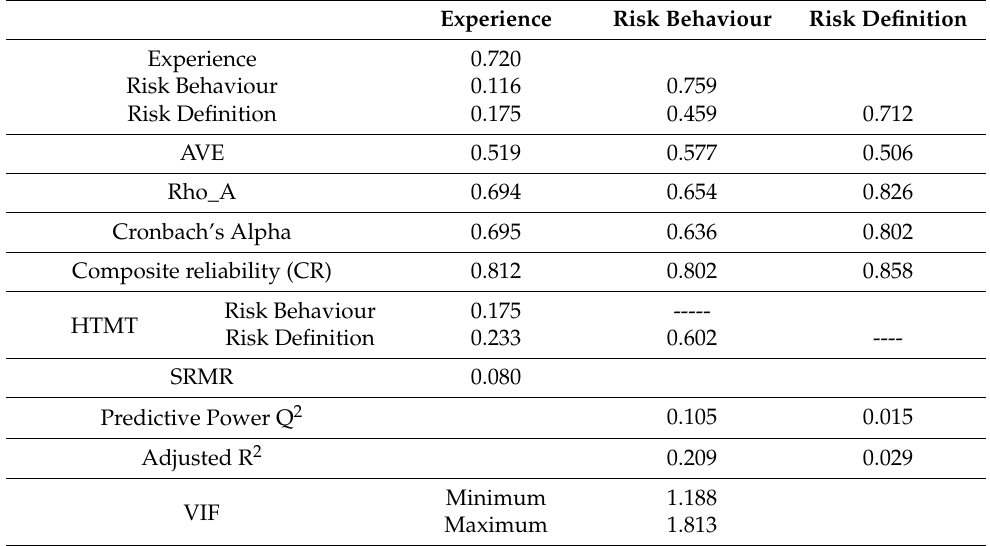
Table 6. Evaluation of Reflective Measurement Models and Structural Models for Model